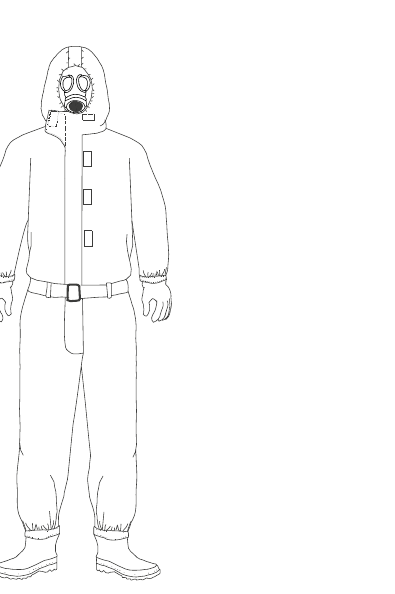
Figure 2. Experimental ensembles style figure 22 . The figure was created using Coreldraw Version